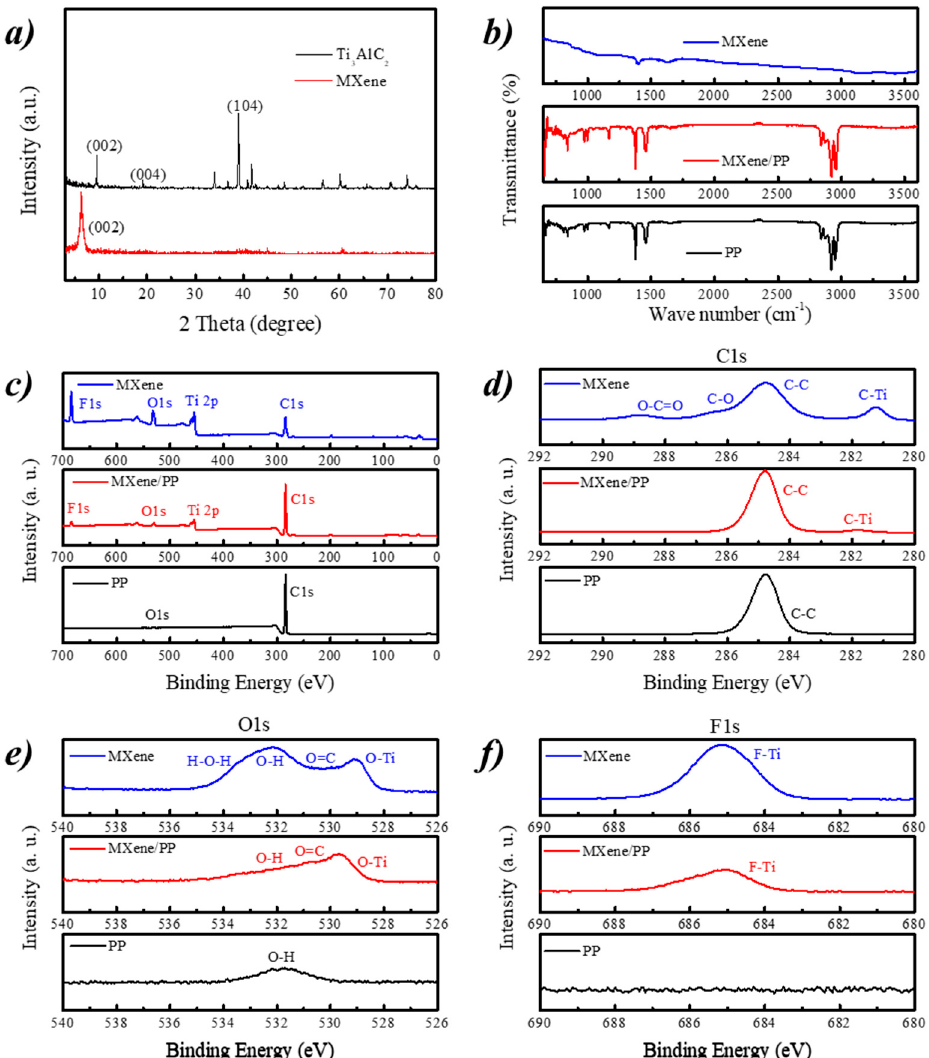
Figure 3. ( a ) XRD patterns of MAX and MXene; ( b ) FT-IR spectra; and ( c ) XPS survey and high resolution of ( d ) C1s, ( e ) O1s, and ( f ) F1s for MXene, PP, and MXene/PP samples.